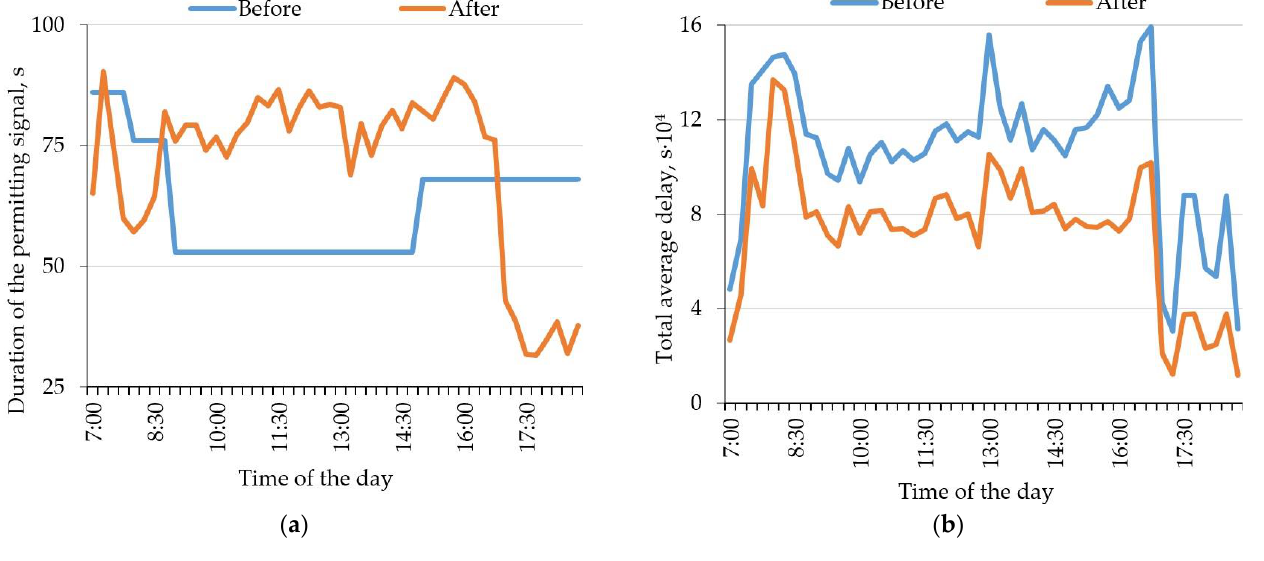
Figure 10. Operation of the regulated intersection before and after adjustment: ( a ) the duration of the resolving signal of the left-turn direction; ( b ) the total average delay of vehicles.